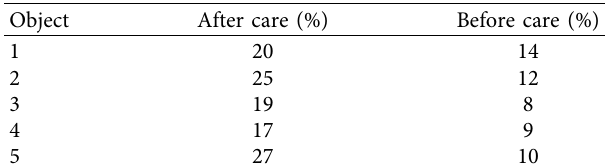
Figure 8: Major injury factors for athletes from 2016 to 2020. Table 6: Recovery speed of ankle joint injury before and after rehabilitation